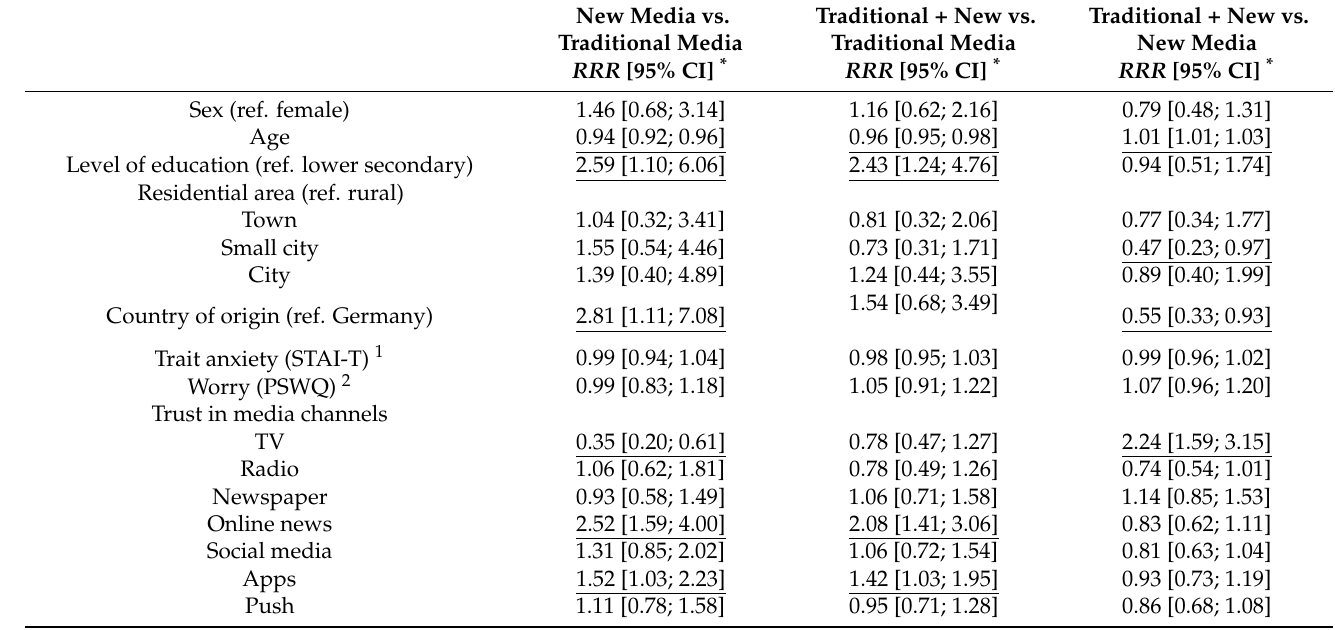
Table 2. Results of the multinomial logistic regression of types of media use (i.e., traditional, new, or mixed media) predicted by sociodemographic (sex, age, education, residential area, country of origin) as well as psychosocial variables (anxiety, worry, trust in media channels) (imputed data set; N = 613). Traditional + New Traditional + New vs. New Media vs. Traditional Media Traditional Media RRR [95% CI] * RRR [95% CI] *